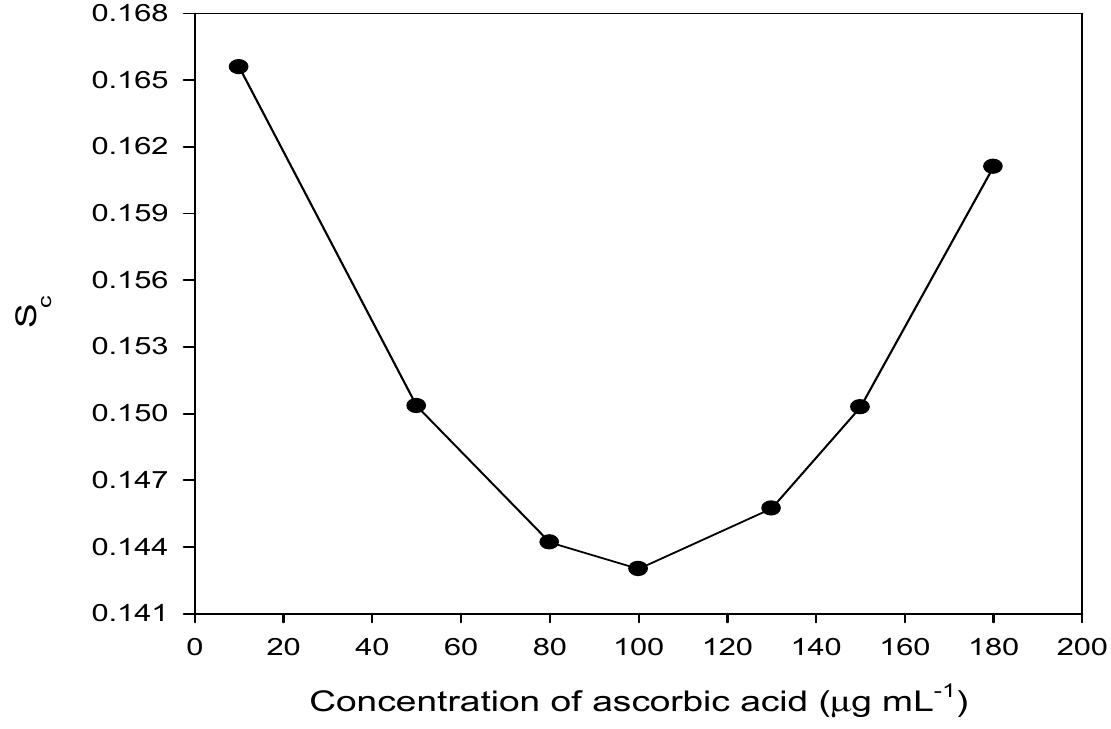
Figure 5. Uncertainty error (S c ) in the determination of ascorbic acid.